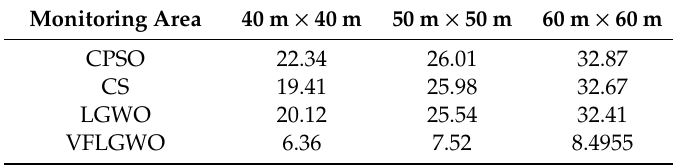
Table 11. Average moving distance of sensor nodes in di ff erent size monitoring areas.